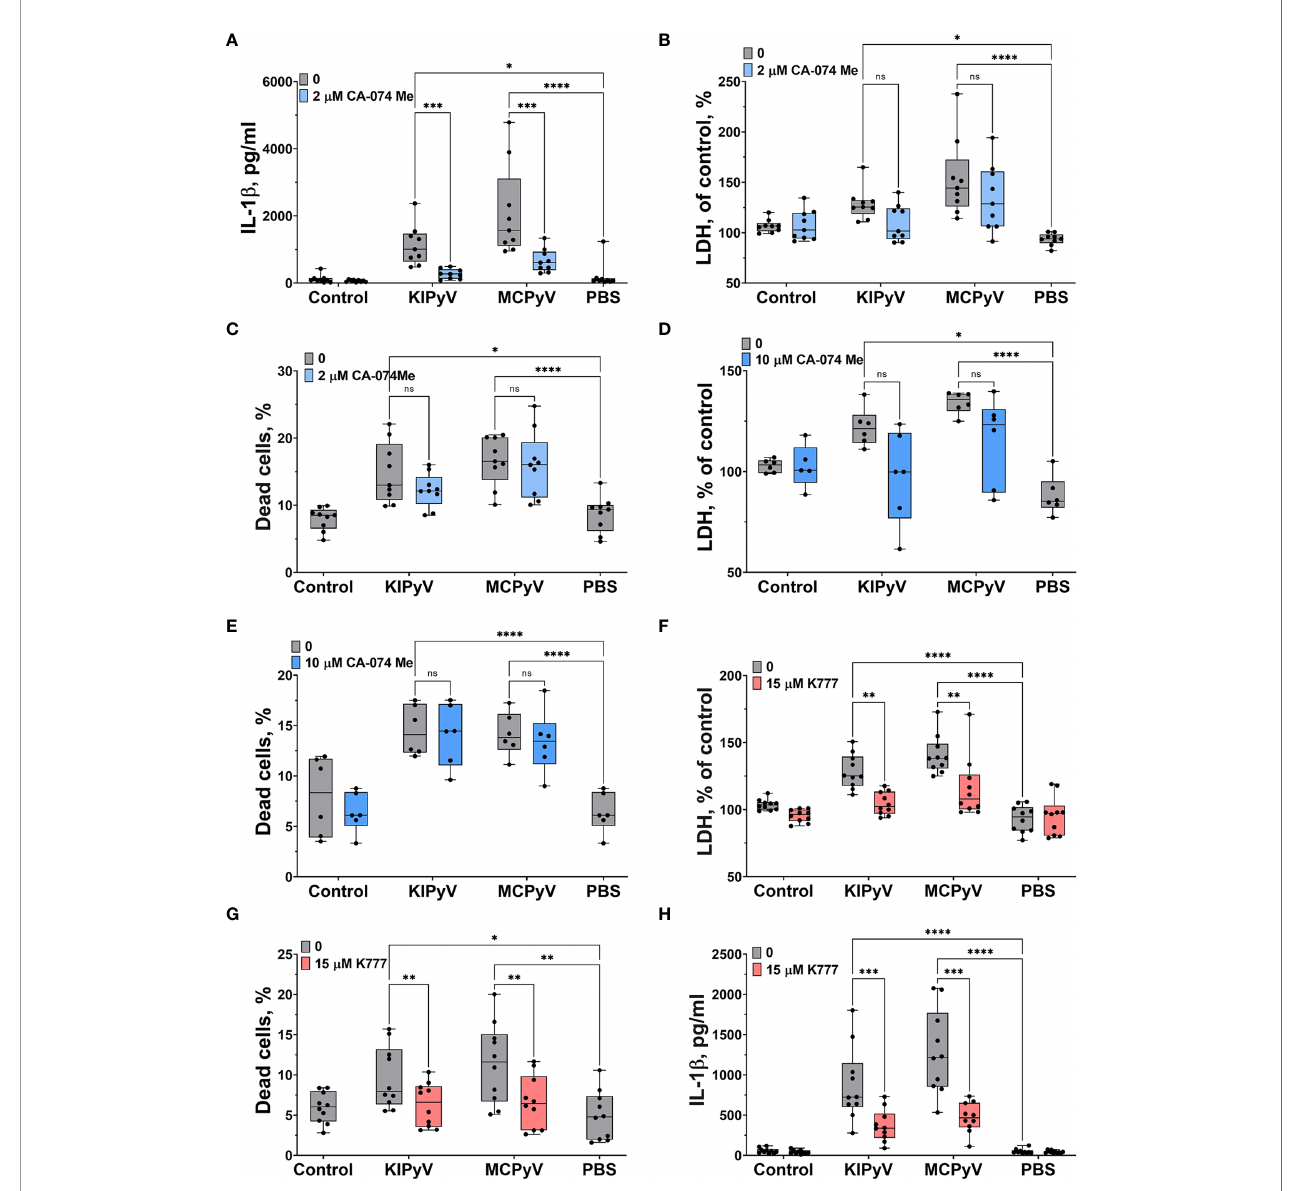
FIGURE 5 | Cathepsin B inhibitor reduced VLP-induced IL-1 b release while pan-cathepsin inhibitor decreased both IL-1 b release and cell death in human THP-1 macrophages. Macrophages were treated with PyV-derived VLPs (20 µg/ml) for 24 h. Inhibitors CA-074 Me (2 or 10 m M) and K777 (15 m M) were added 30 min before treatment. (A, H) IL-1 b secretion by ELISA. Cytotoxicity assessed by (B, D, F) LDH assay and (C, E, G) PI and Hoechst nuclear staining. PI indicates dead cells (red) and Hoechst stains all cell nuclei (blue). Data are represented using box plots with dots showing independent experiments, * p < 0.05, ** p < 0.01, *** p < 0.001, **** p < 0.0001, one-way ANOVA followed by Tukey ’ s multiple comparison test; ns, not statistically signi fi